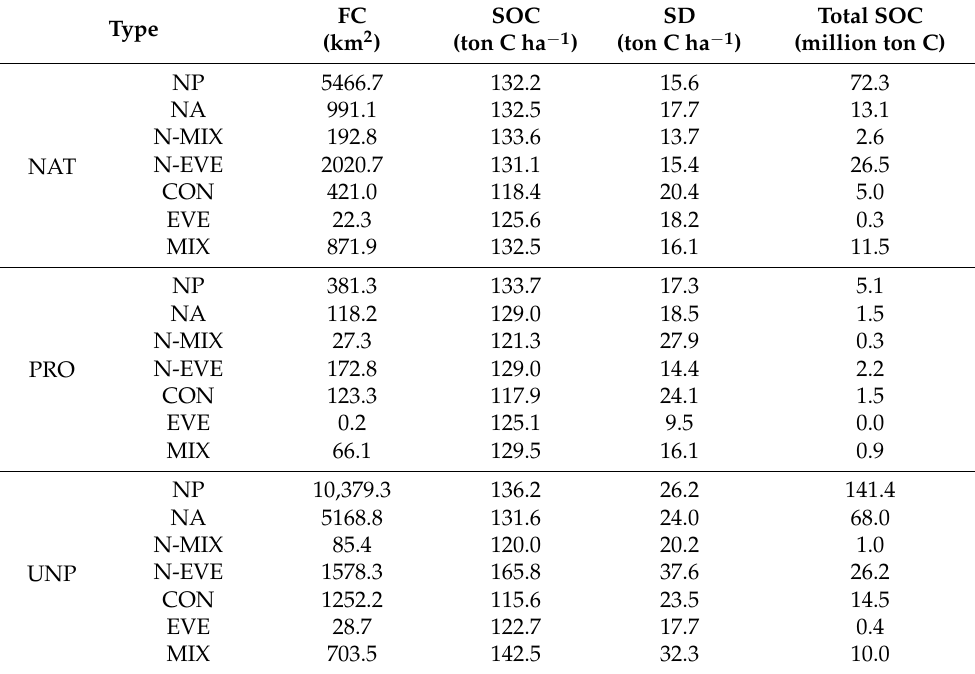
Table A3. Forest cover (FC, km 2 ), mean soil organic carbon content (SOC, ton C ha − 1 ) and standard deviation (SD, ton C ha − 1 ) to calculate total C stock (million ton C) classified by reserve